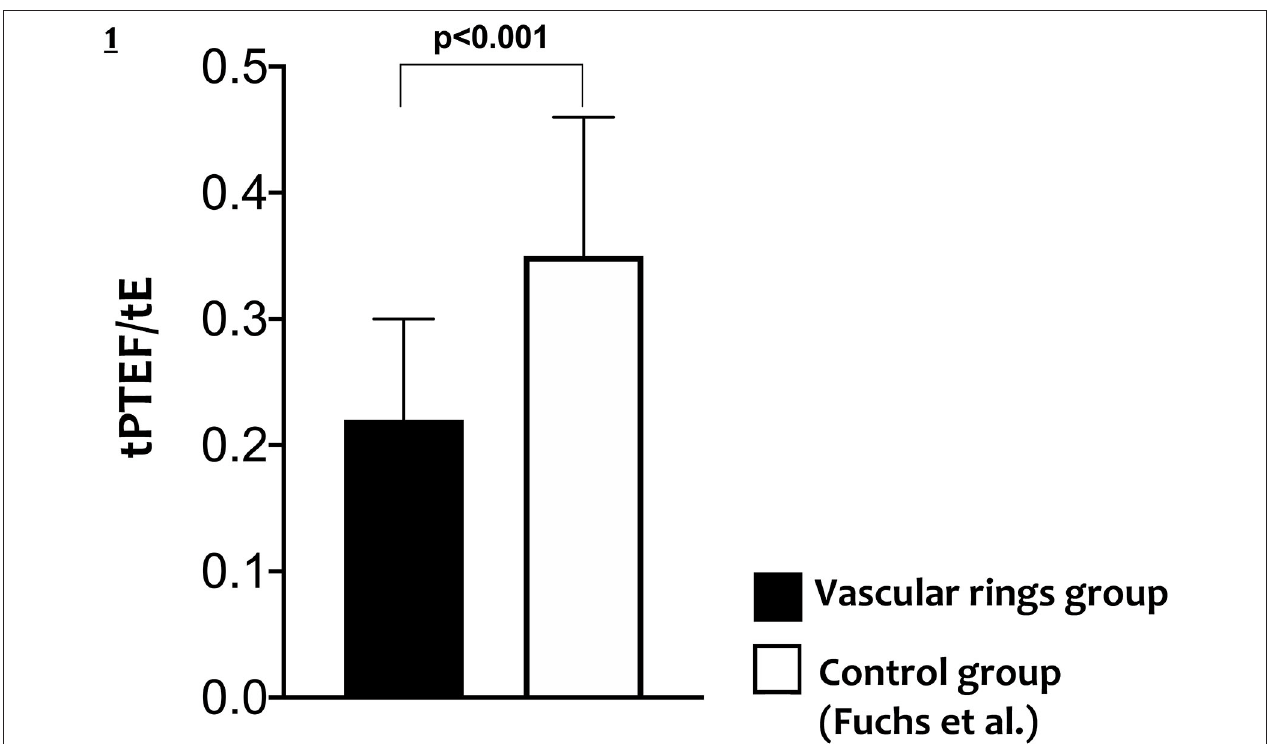
FIGURE 1 | Differences in tPTEF/tE in cases with vascular rings and in controls.